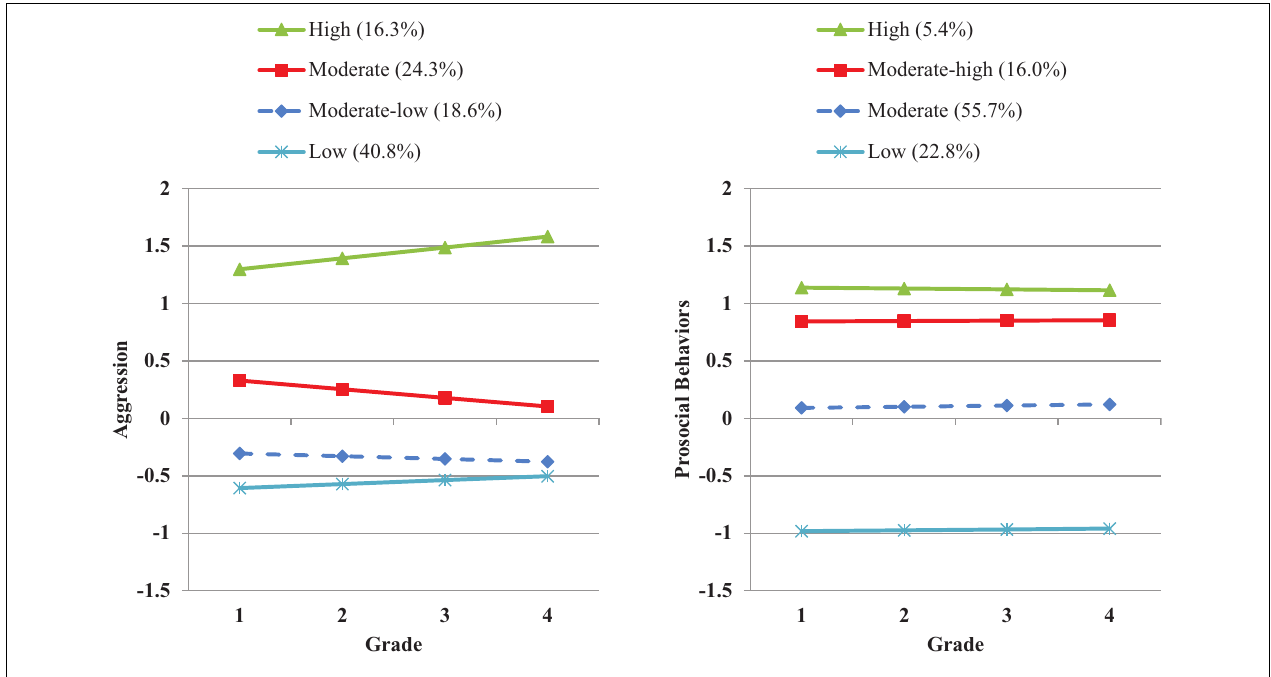
FIGURE 1 | Developmental trajectories (and class percentages) for aggression and prosocial behaviors from Grades 1 to 4.